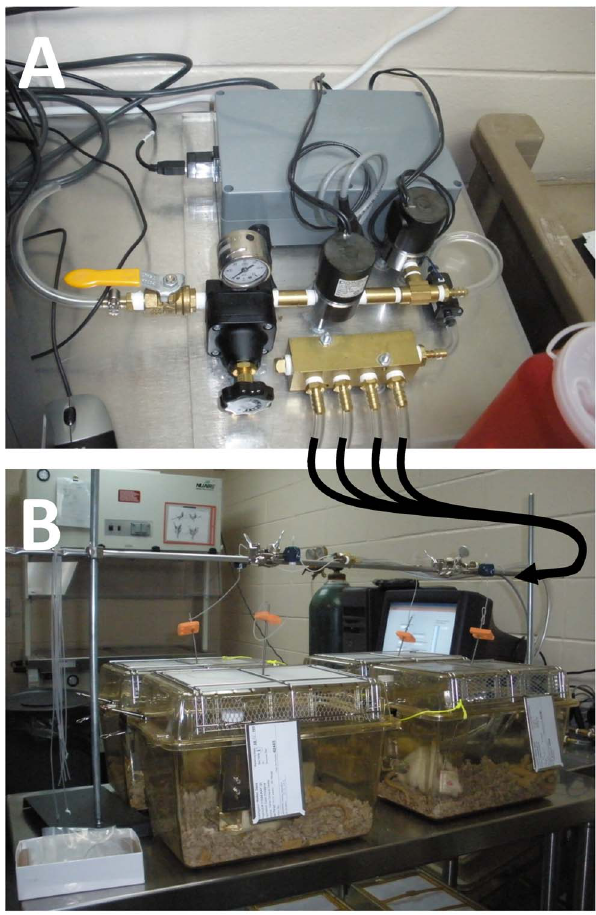
Figure 3. The automated catheter inflation device (A) and example of cardiac ischemia study using the device (B). The curved arrows indicate the pressure lines which exit from the manifold in (A) and are connected to the implanted balloon catheters in (B) via rotating couplers.